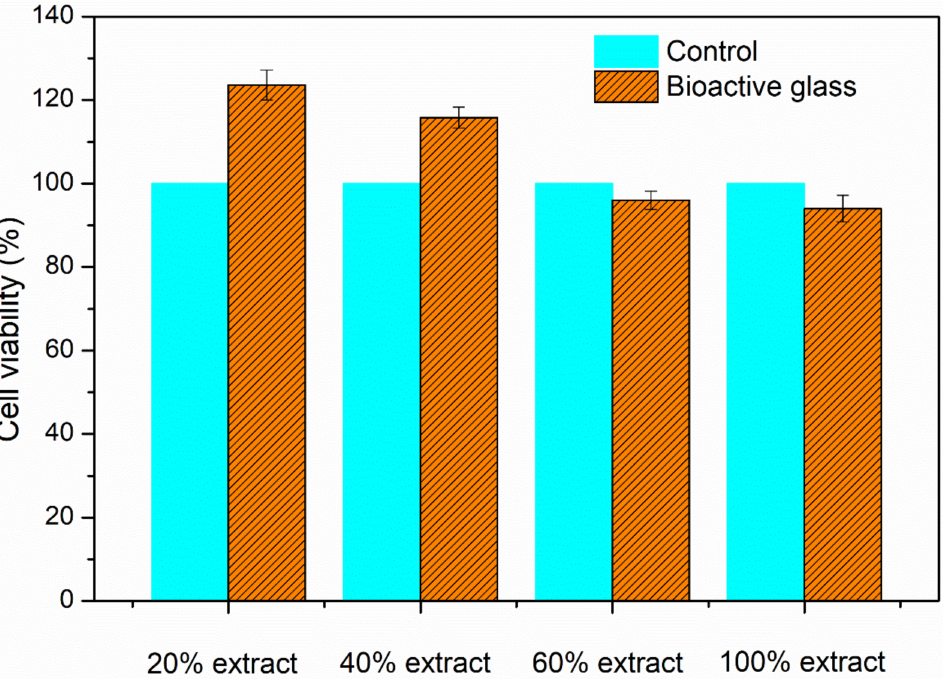
Figure 7. Cell viabilities of synthetic bioactive